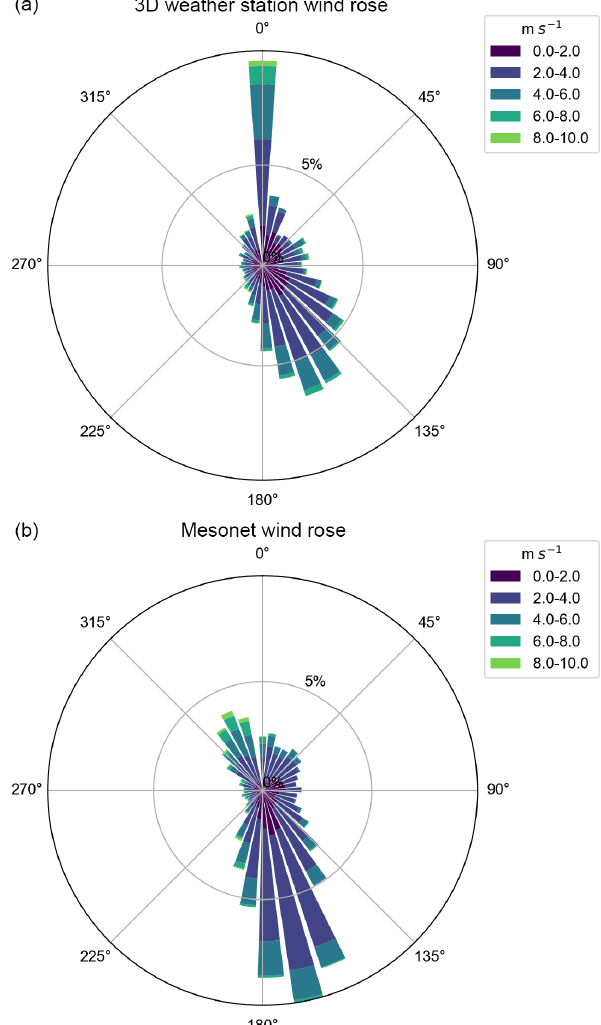
Figure 10. Wind roses for the 3D-printed wind vane using a Hall effect rotary sensor (a) and the Oklahoma Mesonet (b) for the entire deployment. Color coding is based on the percent occurrence of wind speeds noted in the